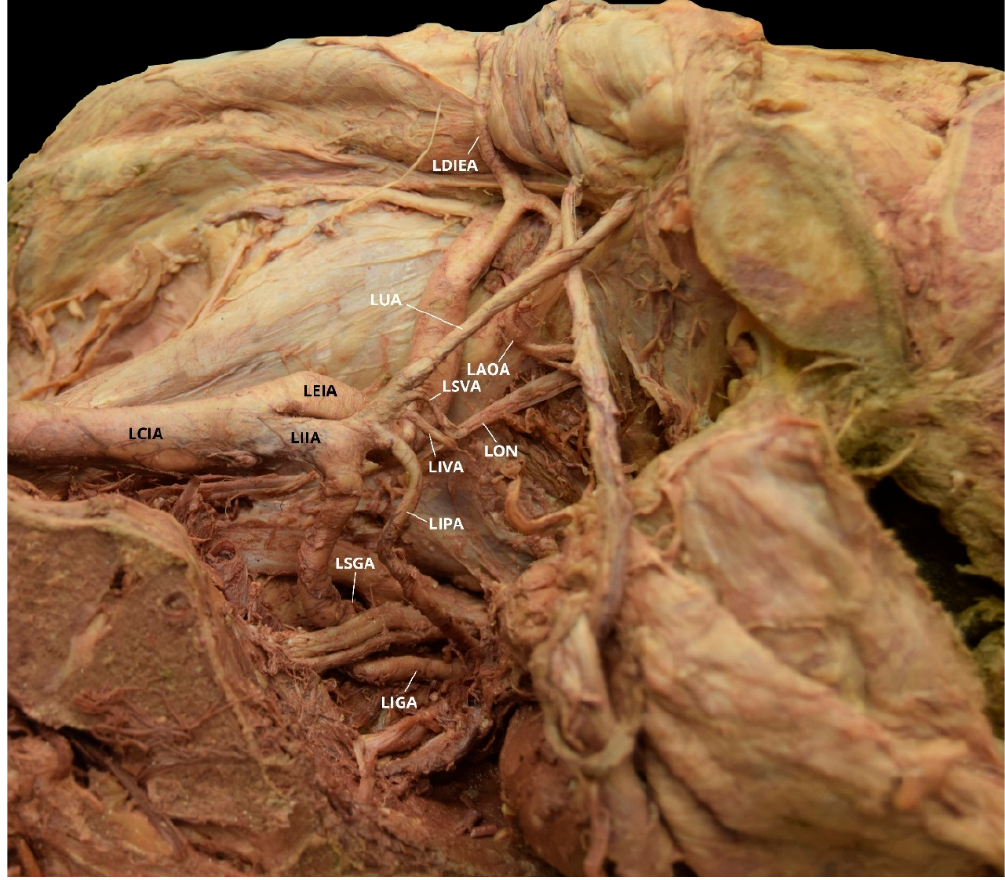
Figure 3. Facilitated display highlighting the left internal iliac artery branches with the left aberrant obturator artery for Case 2. LAOA = Left Aberrant Obturator Artery; LCIA = Left Common Iliac Artery; LDIEA = Left Deep Inferior Epigastric Artery; LEIA = Left External Iliac Artery; LIGA = Left Inferior Gluteal Artery; LIIA = Left Internal Iliac Artery; LIPA = Left Internal Pudendal Artery; LIVA = Left Inferior Vesical Artery; LON = Left Obturator Nerve; LSGA = Left Superior Gluteal Artery; LSVA = Left Superior Vesical Artery; LUA = Left Umbilical Artery. The Left Iliolumbar Artery (LILA), Left Superior Lateral Sacral Artery (LSLSA), Left Inferior Lateral Sacral Artery (LILSA), and the Left Middle Rectal Artery (LMRA) are not pictured.